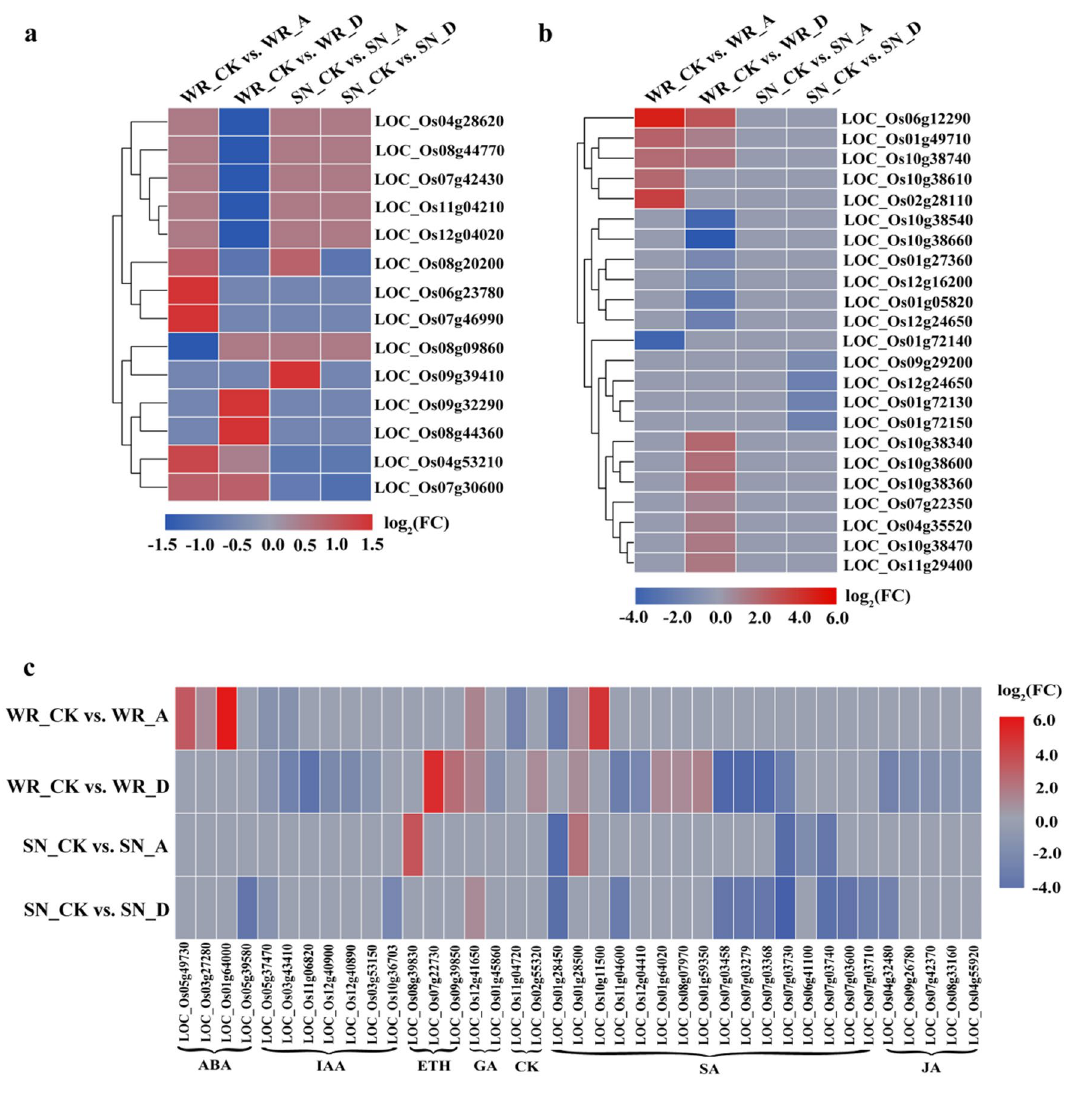
Figure 5. DEGs relevant to peroxisome, glutathione metabolism, and hormone signaling after treatment with ABA or diniconazole. ( a ) Change in transcript expression levels associated with peroxisomes in WR04-6 and SN9816 plants after ABA and diniconazole treatment. ( b ) Expression patterns of genes involved in the glutathione metabolism pathway in the four pairwise transcriptome comparisons. ( c ) DEGs involved in hormone signaling in response to ABA and diniconazole treatment in WR04-6 and SN9816 plants. Gene expression levels were transformed by log 2 (FPKM) values. Red and blue represent up-regulation and down- regulation, respectively. A in WR_A or SN_A indicates ABA treatment, D in WR_D or SN_D indicates diniconazole treatment, and CK in WR_CK or SN_CK indicates the control group without